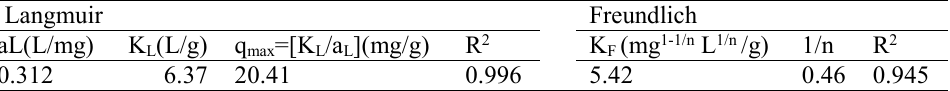
Table 6. Parameters of adsorption isotherm models for the adsorption of perchlorate on Ni-Fe NPs/AC adsorbent